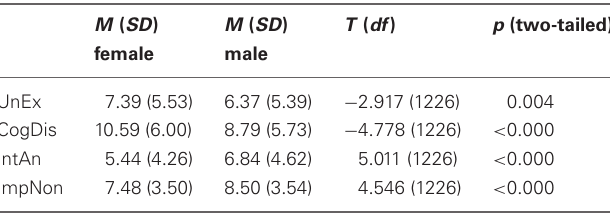
Table 2 | Sex-differences in O-LIFE scale sum-scores.